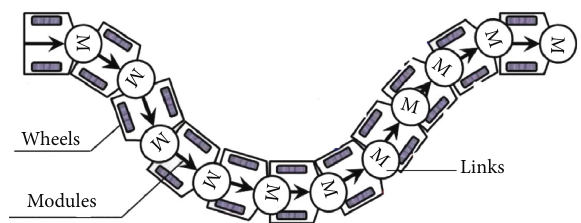
Figure 1: Structural diagram of the snake-shaped